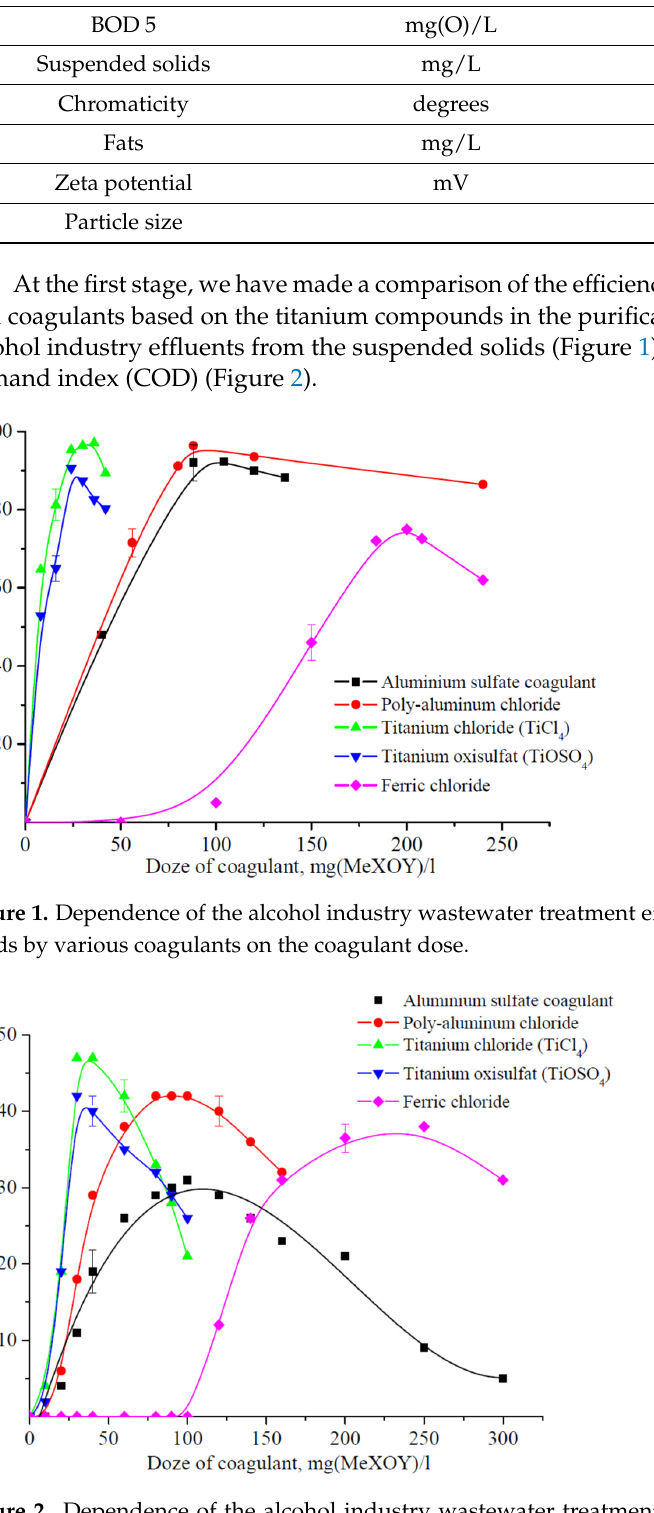
Figure 2. Dependence of the alcohol industry wastewater treatment efficiency from the organic compounds (COD index) by various coagulants.